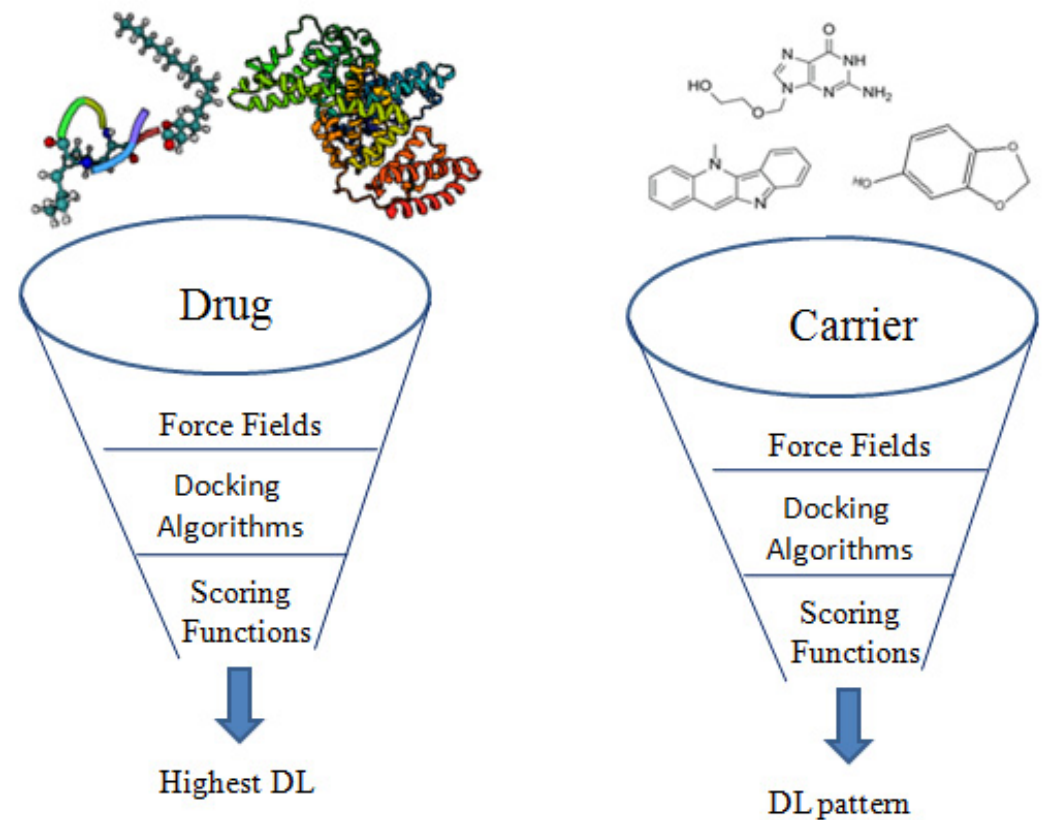
Figure 3. Screening role of different in silico parameters in the drug loading optimization of nanocar- riers. Table 3. Applications of molecular dynamic simulations coupled with docking techniques for modeling drug payload in